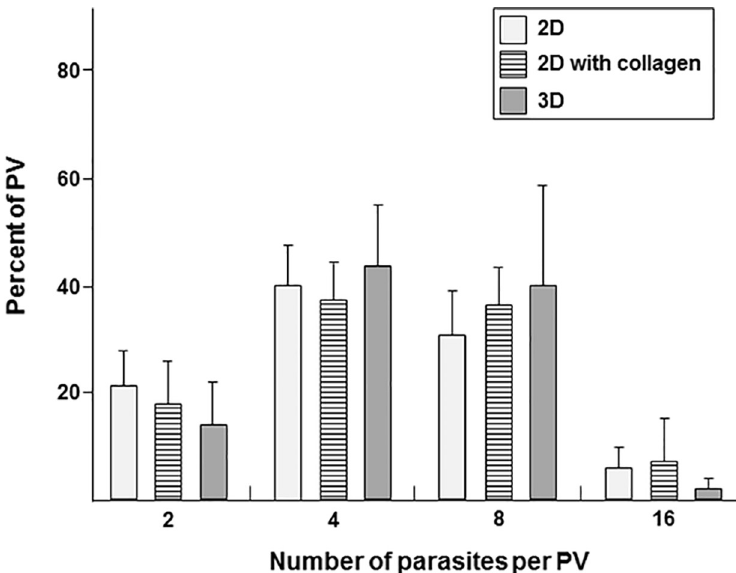
Fig 2. Comparison of parasite replication in 3D collagen matrix with 2D cell monolayers. After 2D cultivation, trypsinized VERO cells were suspended in 3D matrices or placed in the bottom of a 24-well plate either with or without collagen coating for 24 h prior to fixation and parasite counting. Date are means ± SEM, from 4 independent biological samples made in triplicate. No statistical differences between the 2D and 3D conditions were observed (NS; p > 0.05 with χ 2